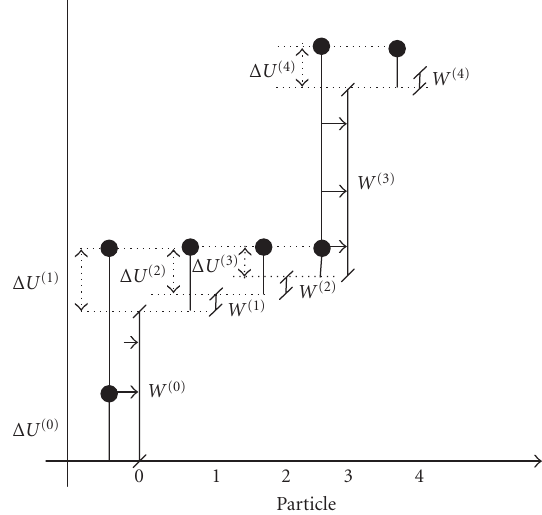
Figure 3: Residual systematic resampling for an example with M = 5